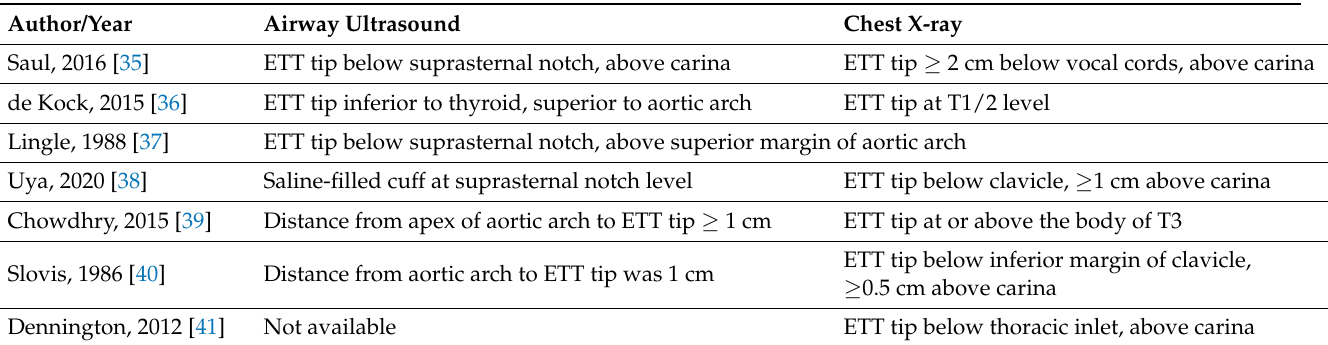
Table 2. Definitions of suitable intubation